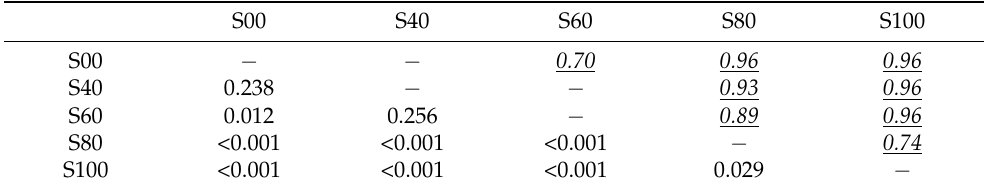
Table 3. p *-values after Bonferroni correction and effect sizes d for pH comparison of small